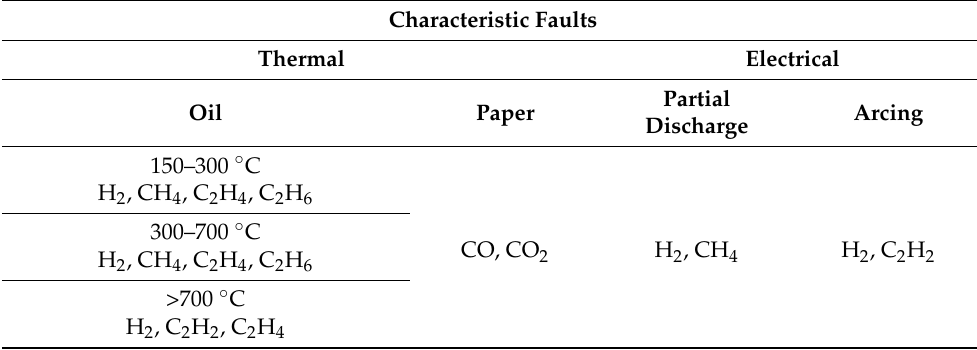
Table 1. Transformer fault classification for monitoring of dissolved in